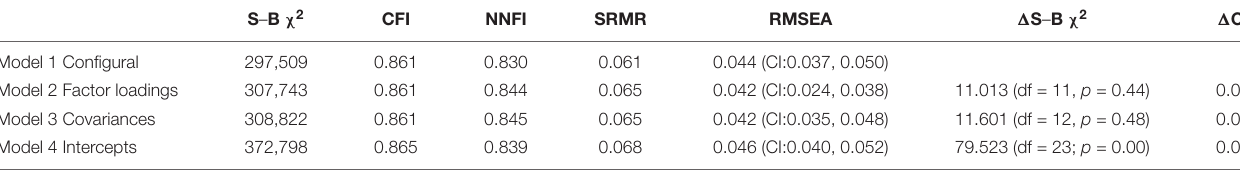
TABLE 6 | Measurement invariance of MS and OFS (two-factor merge model) for males ( n = 176) and females ( n = 524). S – B χ 2 CFI NNFI SRMR